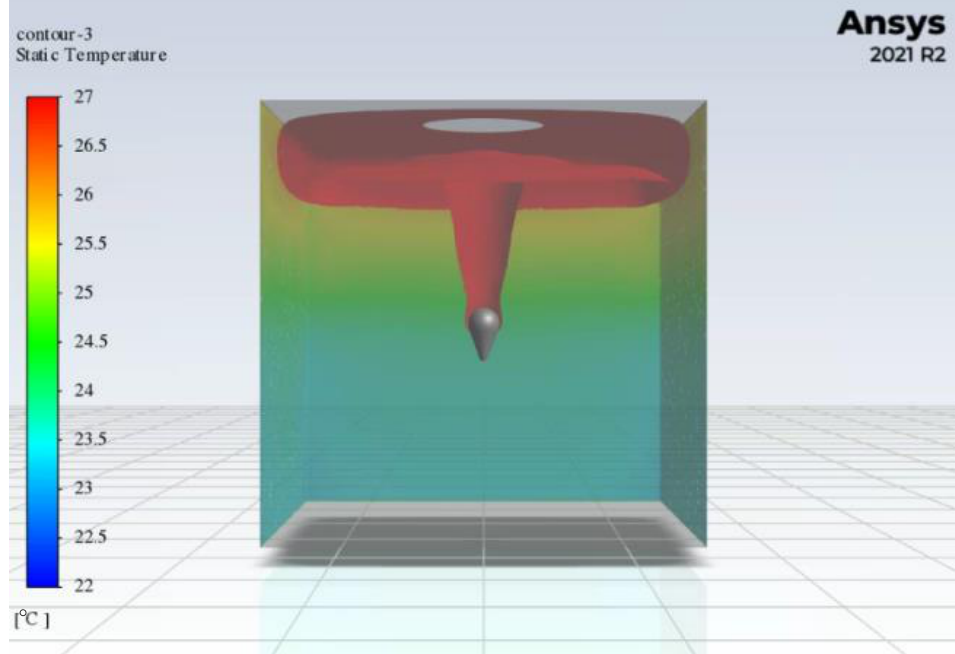
Figure 9. Temperature distribution on the outer surface of the side walls, °C (marked surface — isotherm of 55 °C).